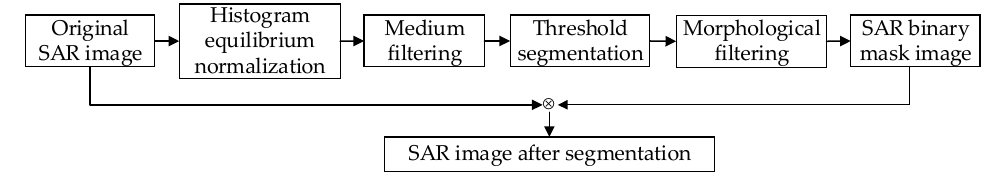
Figure 1. Flow chart of SAR image preprocessing.